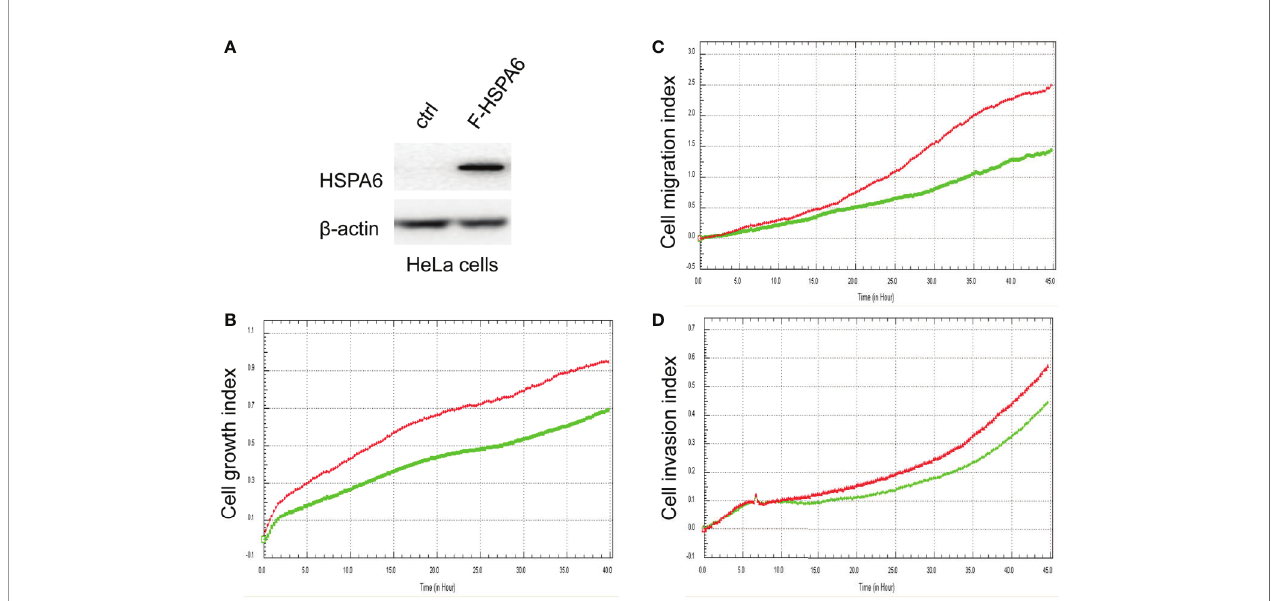
FIGURE 2 | Overexpression of HSPA6 inhibits cancer cell growth, migration and invasion. (A) Overexpression of HSPA6 in HeLa cancer cell line. Lane “ ctrl ” indicates empty vector without HSPA6 expression as a control, whereas lane “ F-HSPA6 ” indicates overexpressions of HSPA6 protein with western blot detected by Flag antibody. b -actin was set as an internal control for total protein loading. (B) Cell growth. (C) Cell migration. (D) Cell invasion. Red lines, controls; green lines, overexpressions of